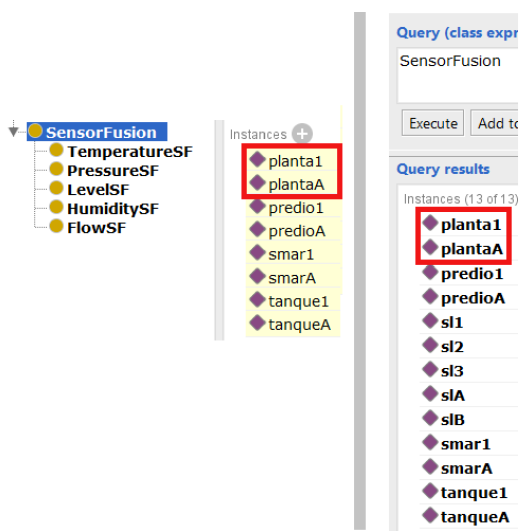
Figure 15. The left side shows resources, production lines, areas and, inside of the red square, sites with sensor fusion. The right side shows the DL Query with all the elements that are in the fusion, including